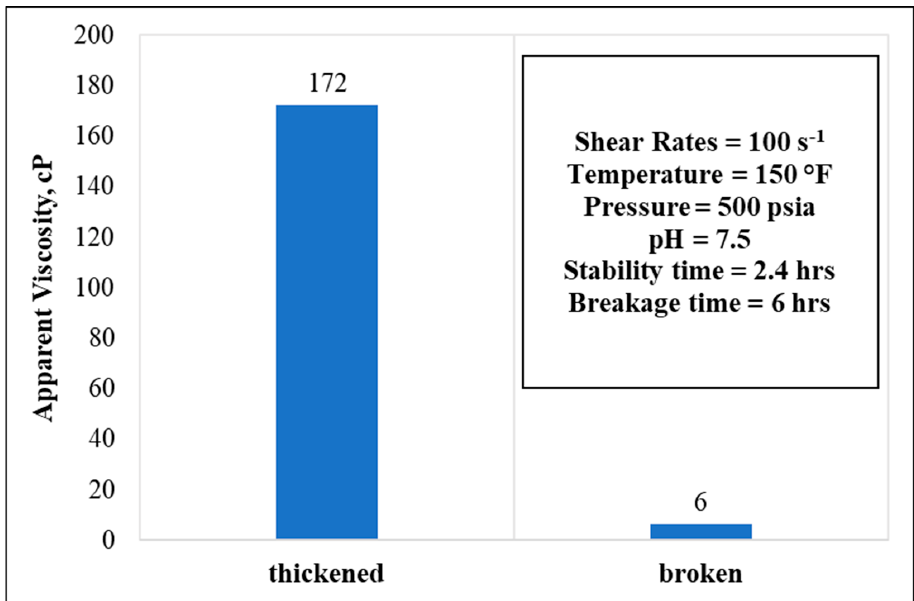
Figure 10. Thickening and breaking behaviors with respective parameters (polymer concentration= 50 pptg, GLDA concentration= 20 wt.%, water salinity = 70 k). However, elevating the temperature while holding the remaining parameters constant clearly showed a variety of stability profiles. As shown in Figure 11 , in a 10 wt.% GLDA, 50 pptg CMHPG polymer concentrations, and at 200 °F temperature, the fluid stabilized for around 1.5 h and broke completely after a total time of 4 h while also showing less apparent viscosity, at 73 cP.